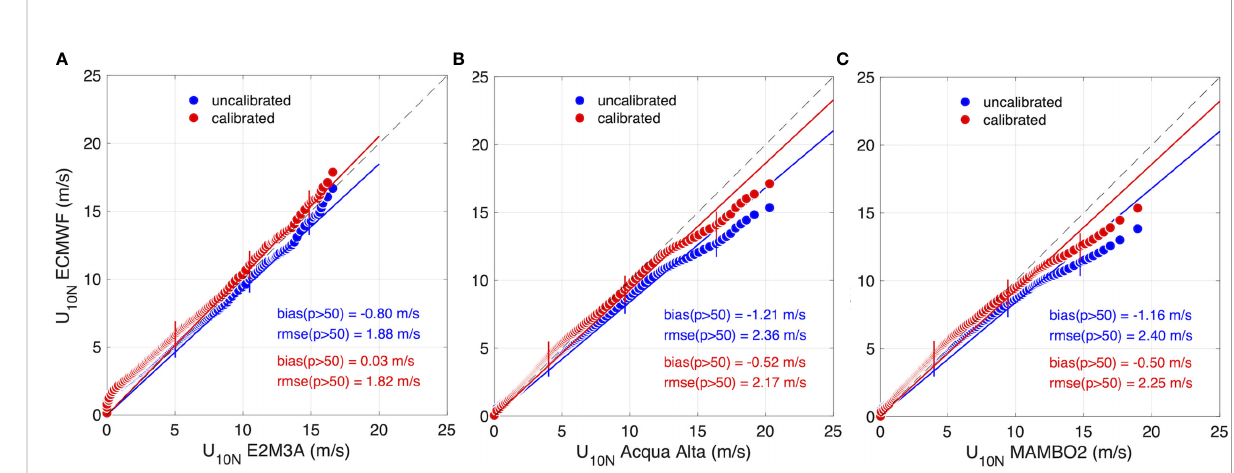
FIGURE 5 Veri fi cation of the wind forcing correction against in-situ wind speed data: comparison of uncorrected and corrected (GQQM) wind speed with observed wind speed at three stations in the Adriatic Sea ("E2M3A" (A) , "Acqua Alta" (B) , "MAMBO2" (C) ; Figure 1). Period: February-December 2021. bias and rmse are computed over the data exceeding the 50 th percentile observed values. Solid lines represent the regression lines and dashed line represent the reference 1:1 Line.